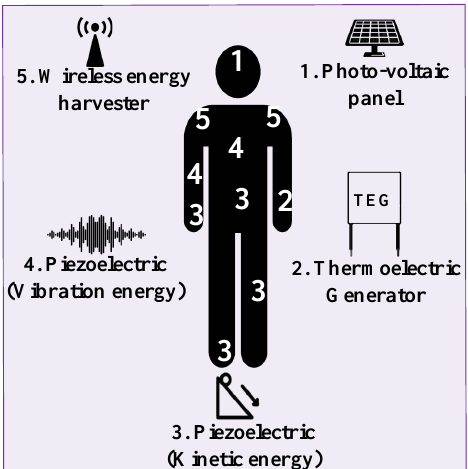
Figure 4. An example of the energy harvesters placement on the human body in the MIoT